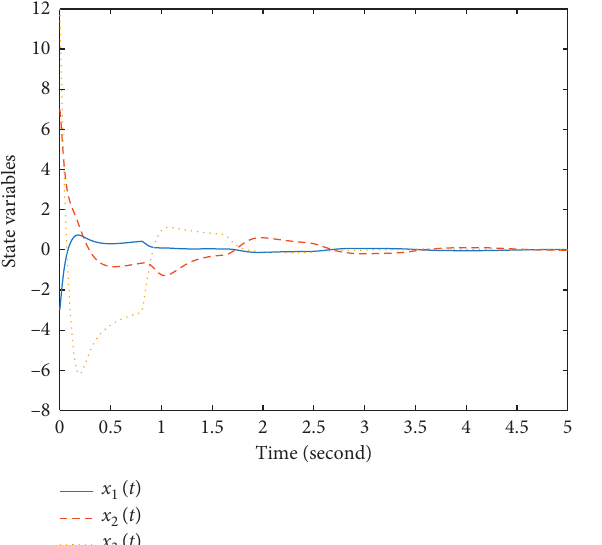
Figure 1: State trajectory of the closed-loop system.